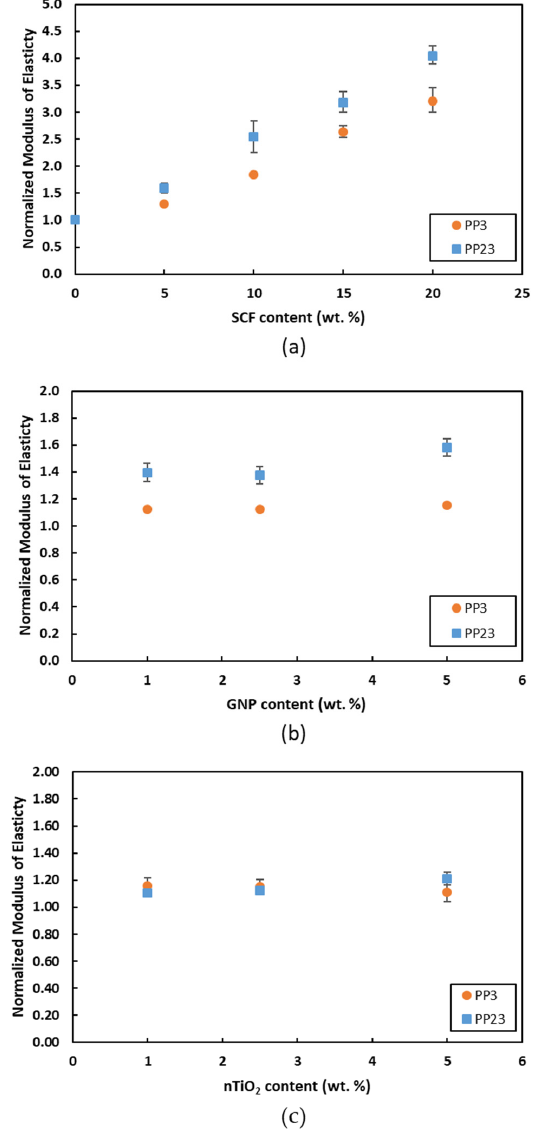
Figure 10. Normalized tensile modulus of ( a ) PP/SCF, ( b ) PP/GNP, and ( c ) PP/nTiO 2 composites.